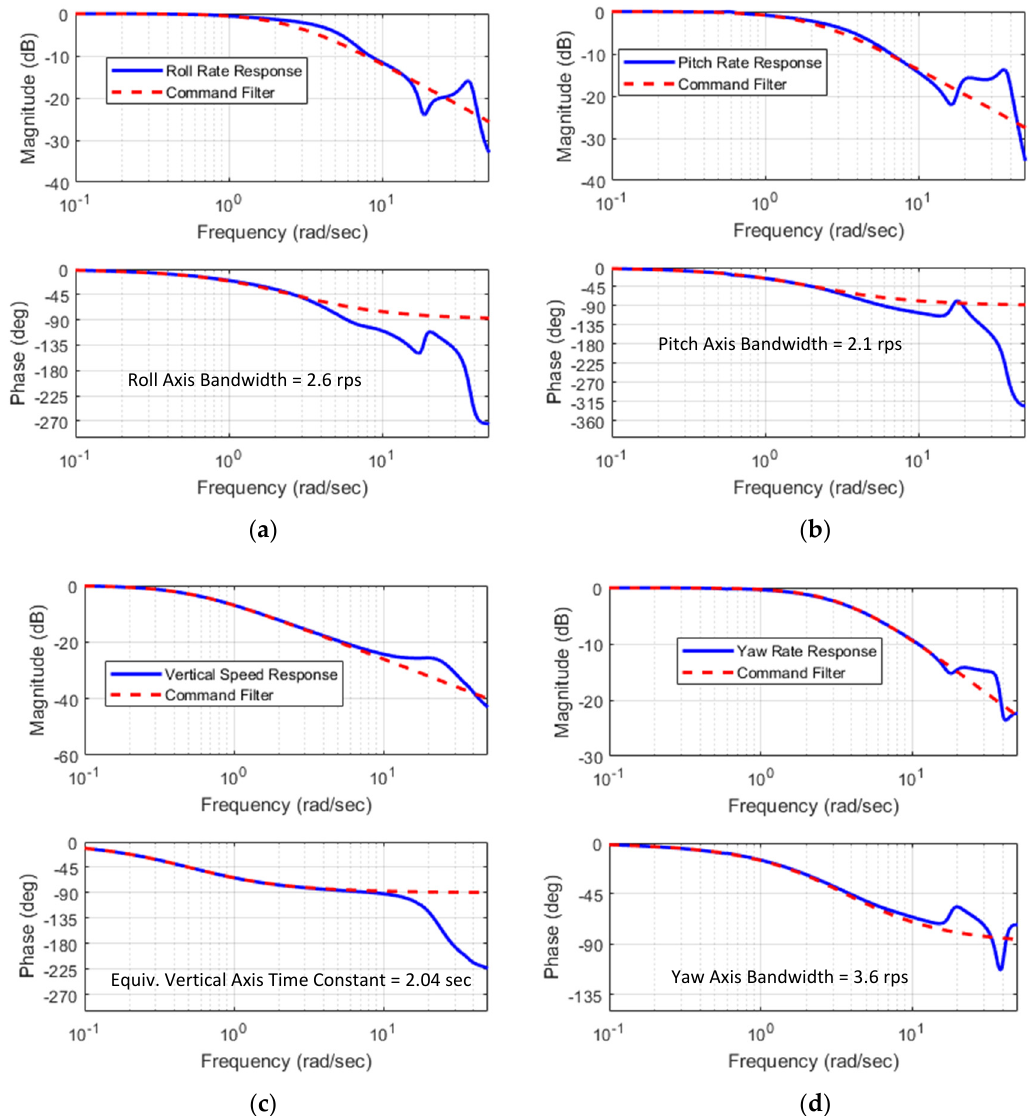
Figure 9. Closed-loop frequency response of the helicopter model at 80 kts: ( a ) roll rate response to commanded roll rate; ( b ) pitch rate response to commanded pitch rate; ( c ) vertical speed response to commanded vertical speed; ( d ) yaw rate response to commanded yaw rate.